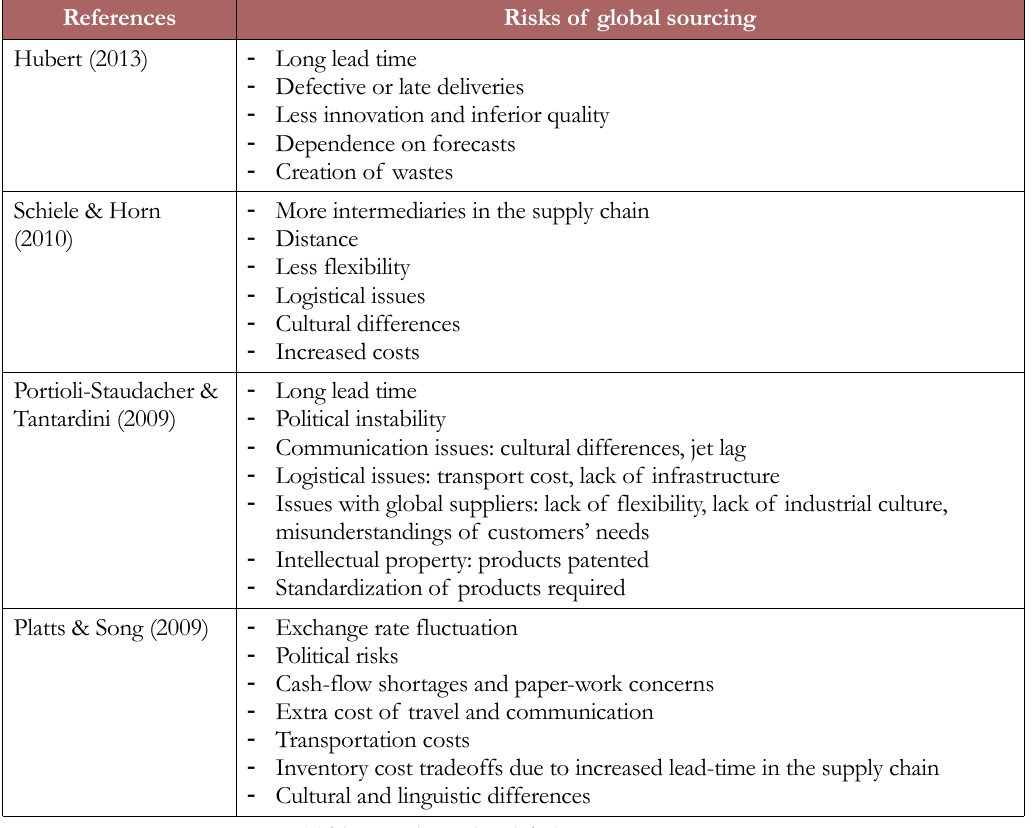
Table 2. Risks in the global sourcing context